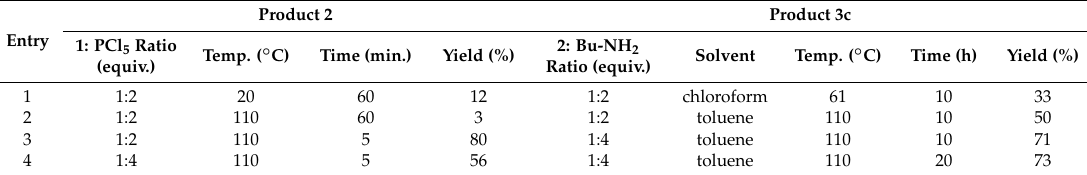
Table 2. The conventional Suzuki cross-coupling reaction for 3,5-bis(biphenyl-4-yl)-4-butyl-4 H -1,2,4- triazole ( 7a ).